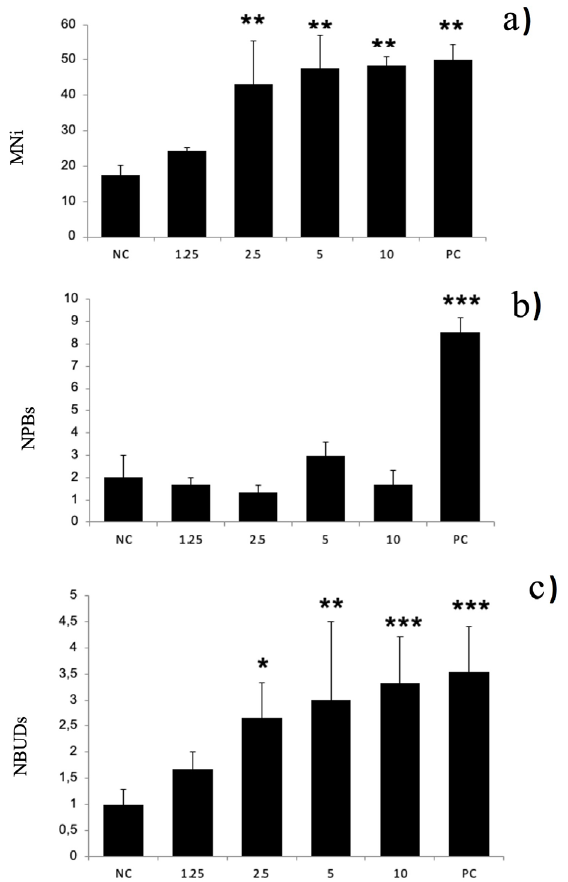
Figure 3. Effects of STX on the frequencies of a) MNi: micronuclei; b) NPBs: nucleoplasmic bridges and c) NBUDs: nuclear buds. Cultured SHSY-5Y cells were exposed to different concentrations (1.25 – 10 µg/L) of STX for 24 h. NC: Negative control. PC: positive control (Bleomycin 3 µg/mL). Significantly different from the negative control group *p<0.05; ** p<0.01; ***